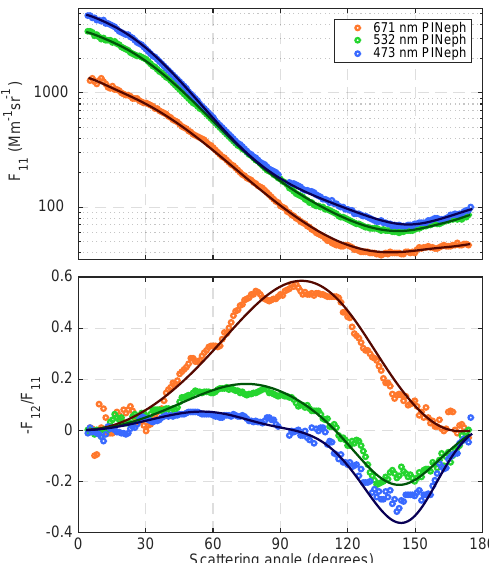
Figure 6. Scattering matrix elements at 473nm (blue), 532nm (green) and 671nm (red) measured in BB plume #1 on 19 August along with the corresponding GRASP fits (solid lines).